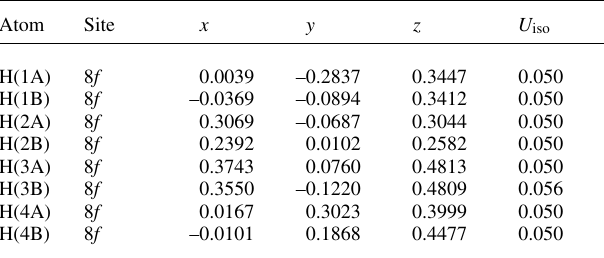
Table 2. Atomic coordinates and displacement parameters (in Å 2 )